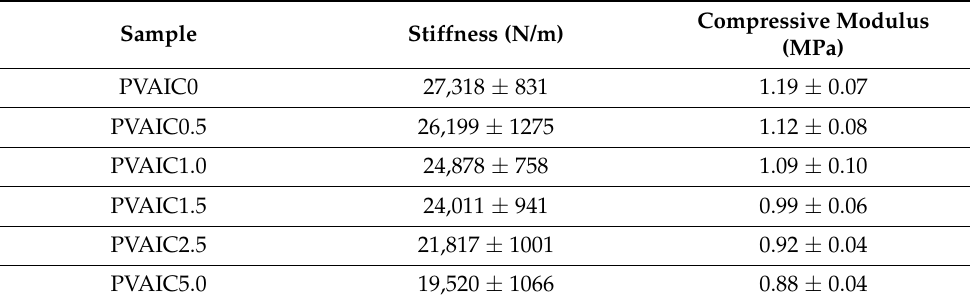
Table 2. Mechanical test of PVA hydrogels containing various amounts of quercetin/HP- β -CD inclusion complex. Data shown as mean ± standard deviation ( n =